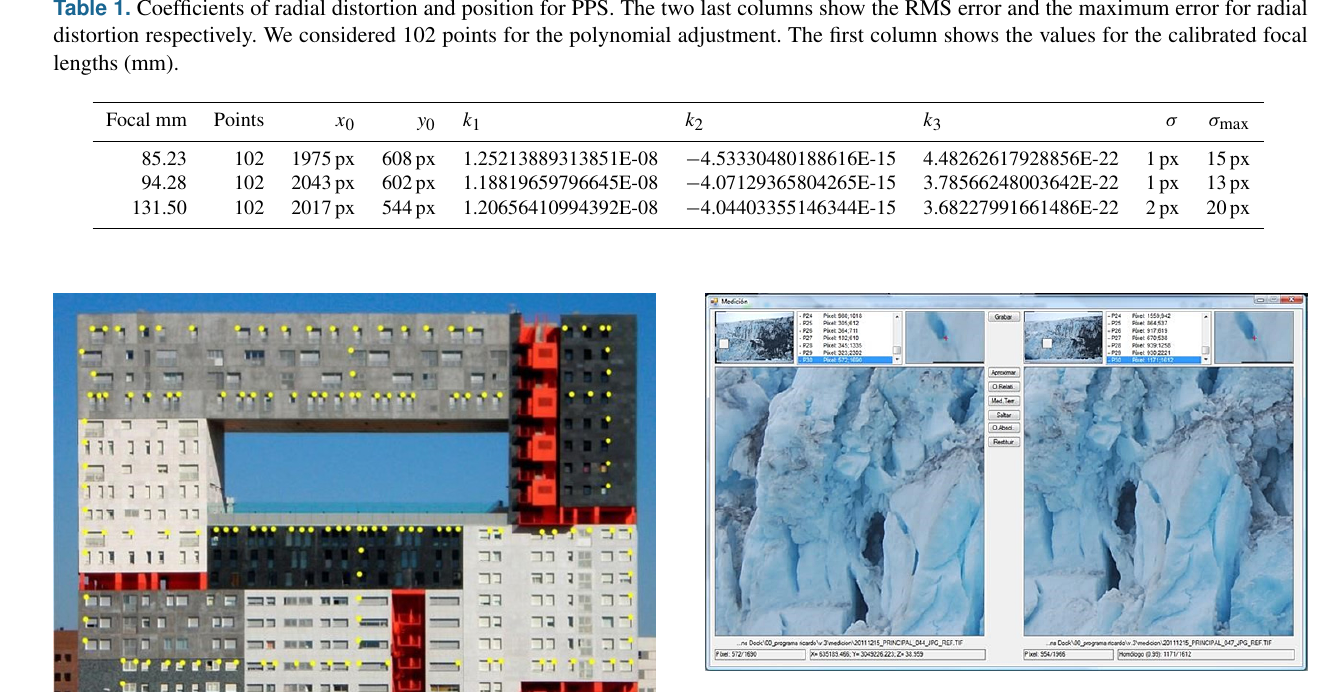
Figure 6. A snapshot of the main screen of our in-house developed software for photogrammetric restitution. This software does not require artificial stereoscopic vision for the restitution. By clicking on an item in the frame to the left, it locates the corresponding point in the right frame using automatic